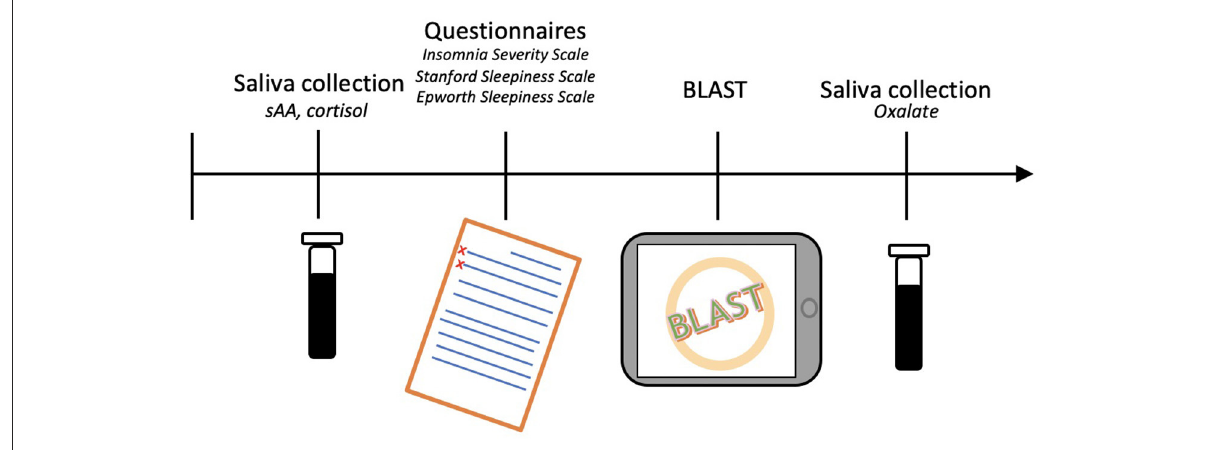
FIGURE1 Study procedure for each participant.